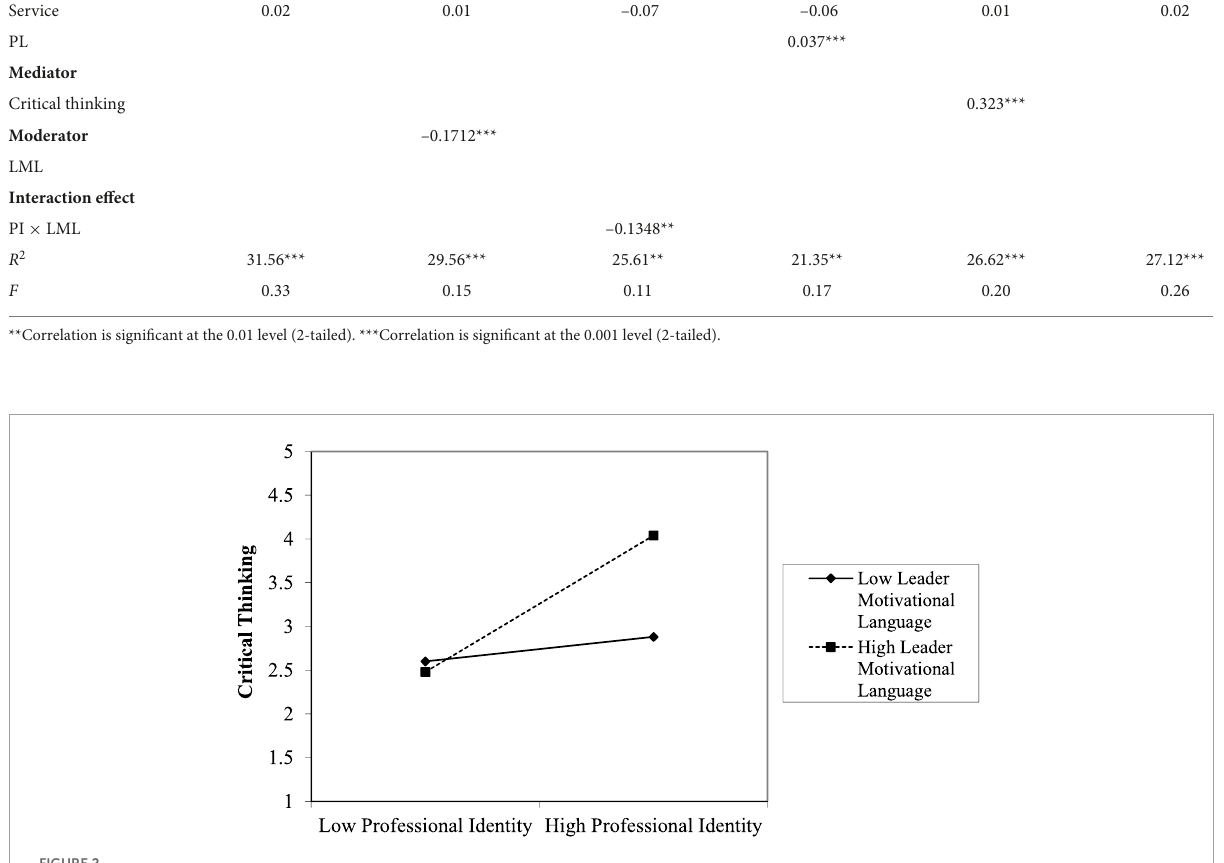
FIGURE2 Moderation effect of leader motivational